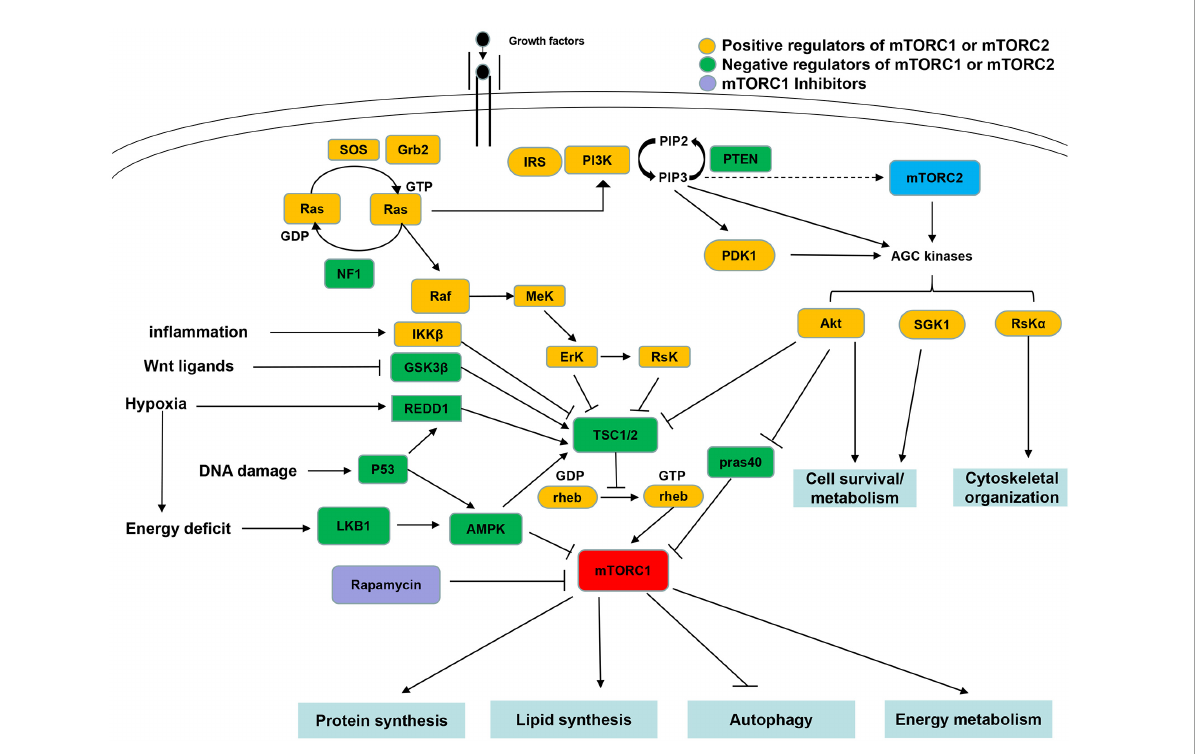
FIGURE1 Diagram of the mammalian target of rapamycin (mTOR) signaling pathways. The signaling upstream and downstream pathways of mTOR complex 1 (mTORC1) and mTOR complex 2 (mTORC2). Positive regulators of mTORC1 signaling are shown in yellow, whereas negative regulators are shown in green. mTORC1 and mTORC2 are shown in red and blue colors, respectively. TSC1/TSC2, tuberous sclerosis complex; PI3K, phosphatidylinositol 3-kinase; and AMPK, adenosine 5’-monophosphate-activated protein kinase.